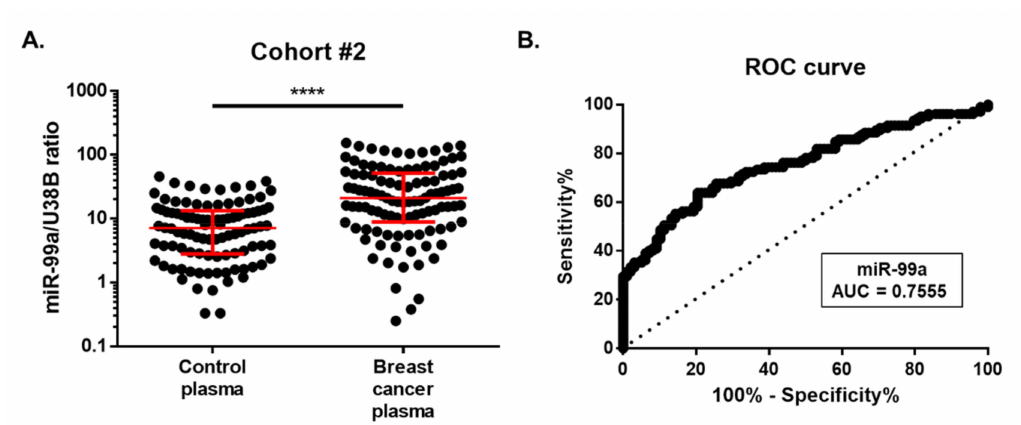
Figure 3. ( A ) Circulating miR-99a levels in cohort #2. Di ff erential miR-99a levels in 105 plasma of breast cancer patients were compared with those of 98 healthy controls. Expression levels were significantly lower in healthy controls than in breast cancer patients. Red horizontal line: median with interquartile range. Mann–Whitney U, **** p < 0.0001. ( B ) Receiver-operating characteristic (ROC) curve analysis for circulating miR-99a levels in cohort